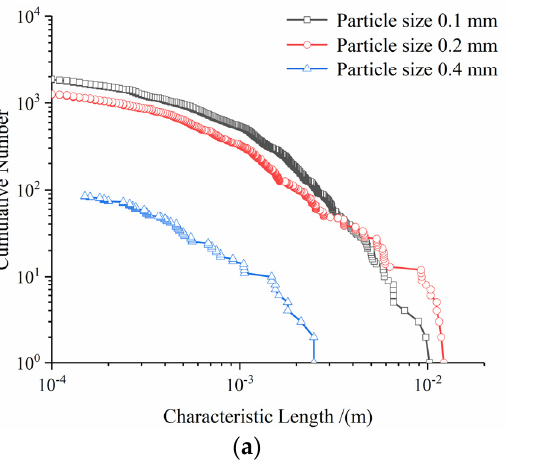
( b ) Figure 10. Mass distribution of debris fragments under different particle sizes. ( a ) Mass distribution of debris fragments under three particle sizes; ( b ) mass (>10 − 7 kg) distribution of debris fragments in the case of finer particles. Finally, the characteristic length–mass relationship of fragments in the logarithmic coordinate system of different particle sizes is presented in Figure 11. According to the